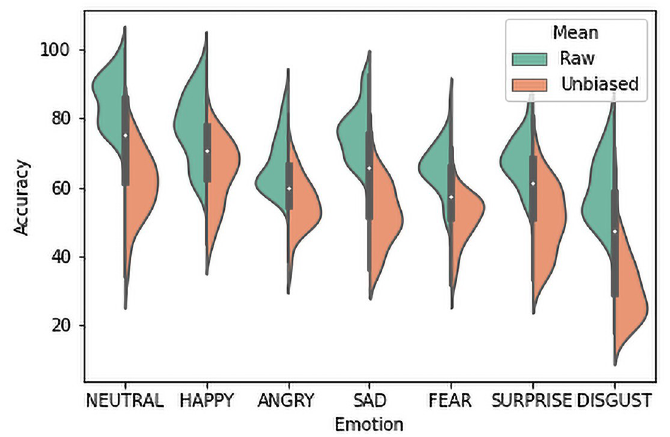
Fig 3. Comparing the raw and unbiased hit rates for Phase